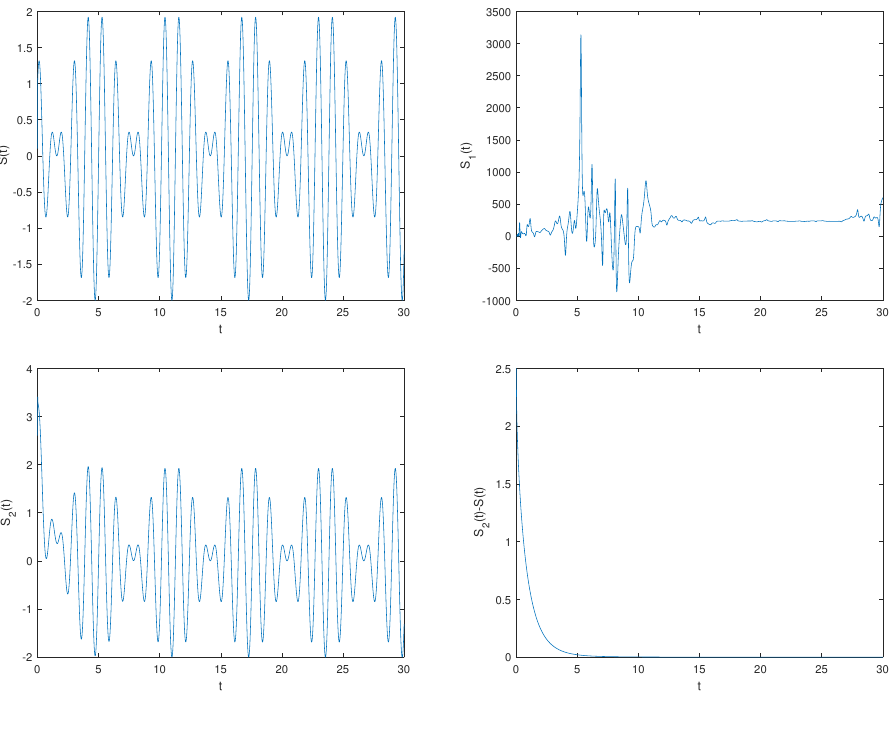
Figure 10. Proposed